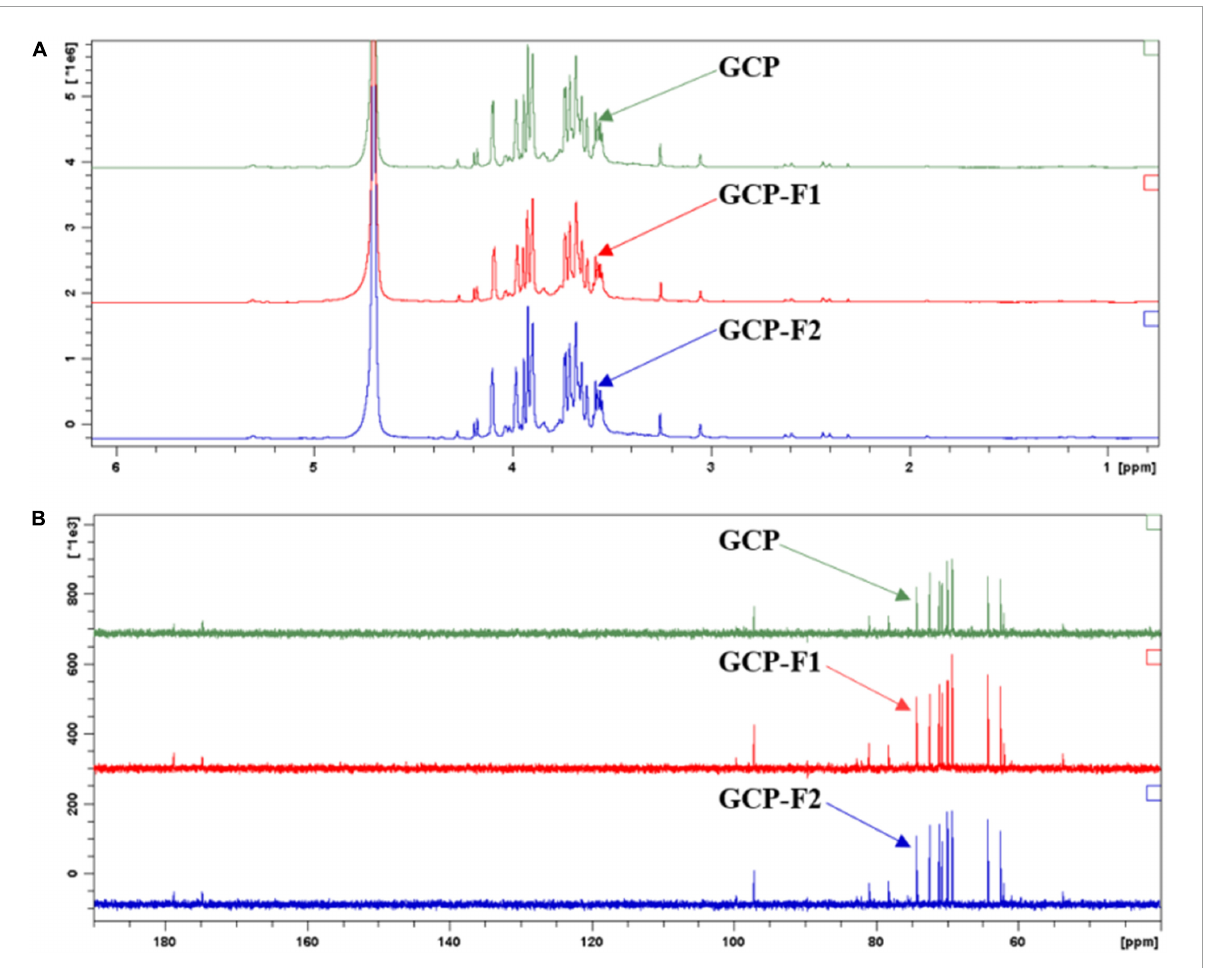
FIGURE3 Nuclear magnetic resonance (NMR) spectroscopic analysis of Genistein Combined Polysaccharide (GCP), GCP-F1, and GCP-F2. (A) 1 H-NMR; (B) 13